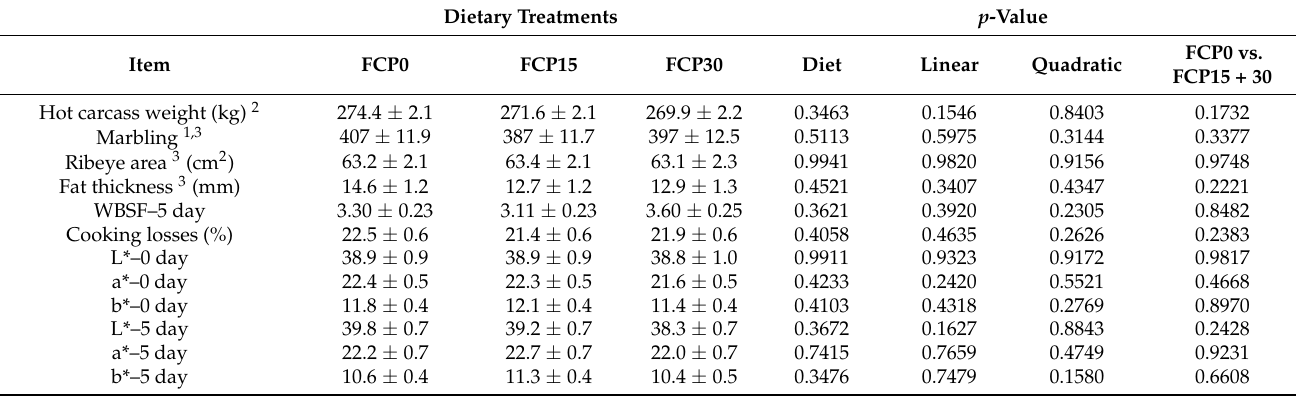
Table 3. Least square means ± standard errors of carcass and meat quality traits according to dietary treatments.